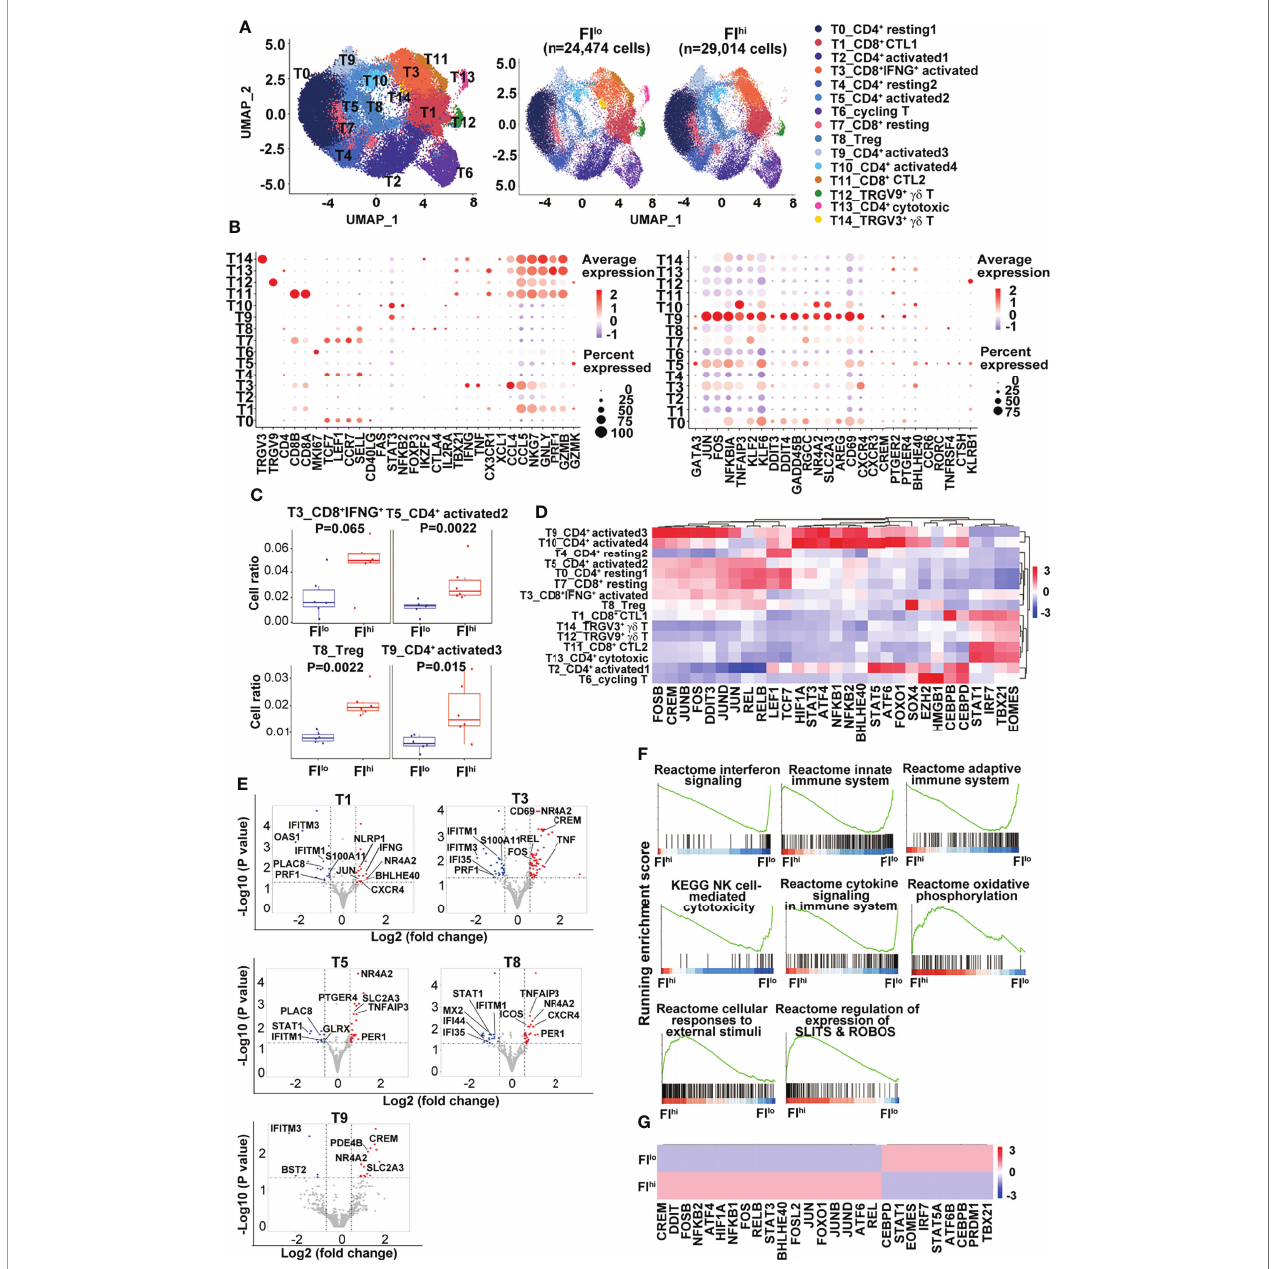
FIGURE 2 | Increased percentage of activated CD4 + T cells and Treg cells in FI hi patients with severe COVID-19. (A) UMAP visualization of T-cell clusters. (B) Dot plot showing the row-scaled expression of selected signature genes for each cluster. (C) Comparison of the proportions of T-cell clusters between FI lo and FI hi COVID patients. (D) Heatmap of the transcription factors of each cluster, with mean area under the curve (AUC) scores are shown. (E) Volcano plot showing DEGs ( p -values < 0.05) in the comparison of each T-cell cluster derived from FI lo and FI hi patients. (F) GSEA analysis of differentially expressed genes (DEGs) in T cells in the comparison of FI lo and FI hi patients with severe COVID-19. (G) Heatmap comparison of the transcription factors in T cells derived from FI lo and FI hi